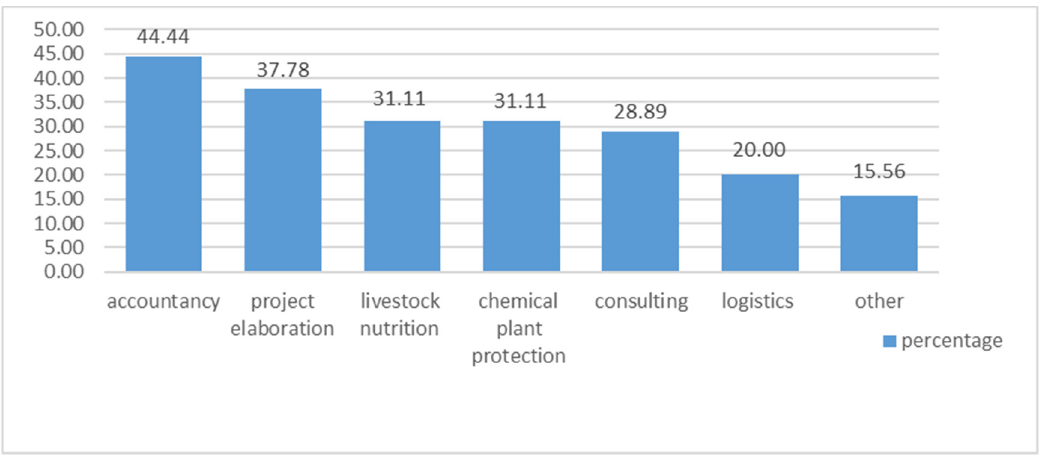
Figure 4. Outsourced activities (Source: own research).